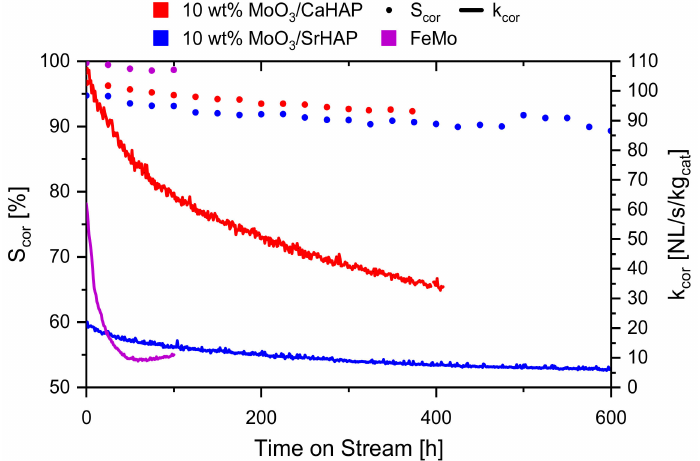
Figure 19. Reversible byproducts corrected selectivity towards FA and corrected activity at 350 ◦ C measured on 25 mg catalyst sample (150–250 µ m) in 150 mg of SiC dilutant in a flow of 150 NmL/min consisting of 5 vol.% MeOH and 10 vol.% O 2 in N 2 . Reprinted from [110] with permission from Wiley-VCH GmbH Copyright ©